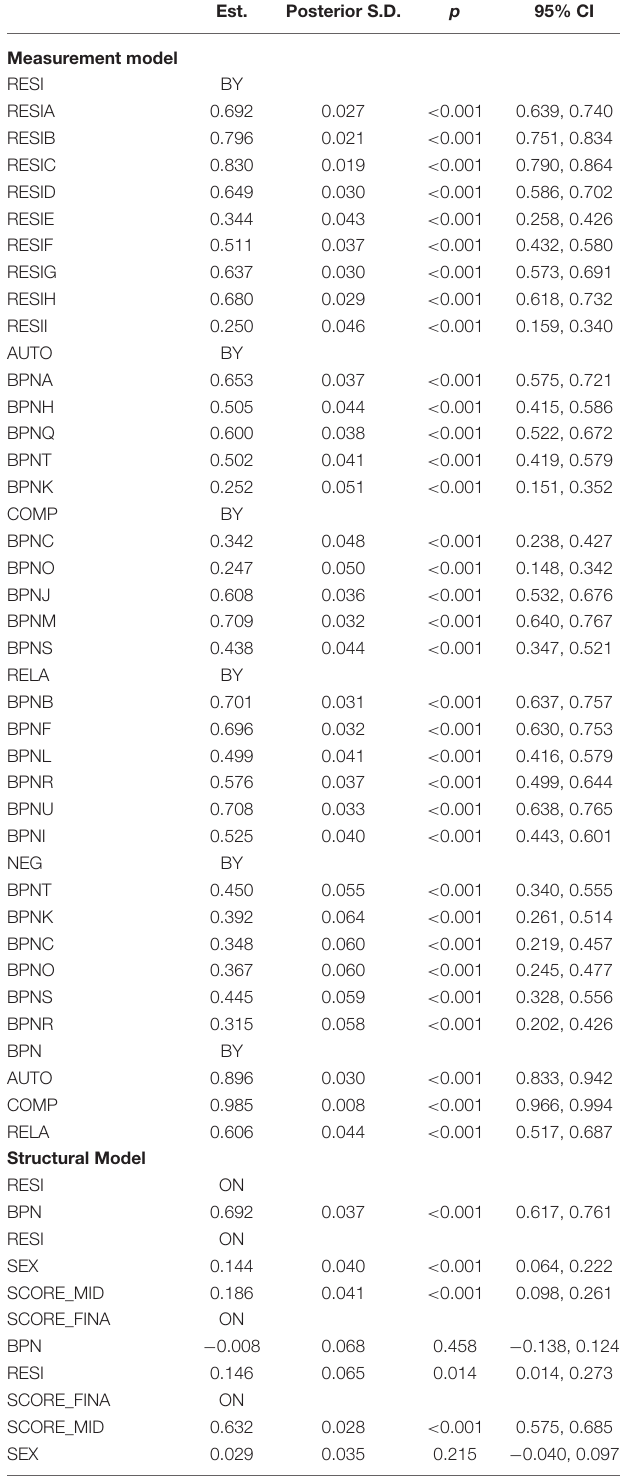
TABLE 2 | Parameter estimates of the relationship between basic psychological needs, resilience, and academic performance (standardized solutions). Est. Posterior S.D. p 95%